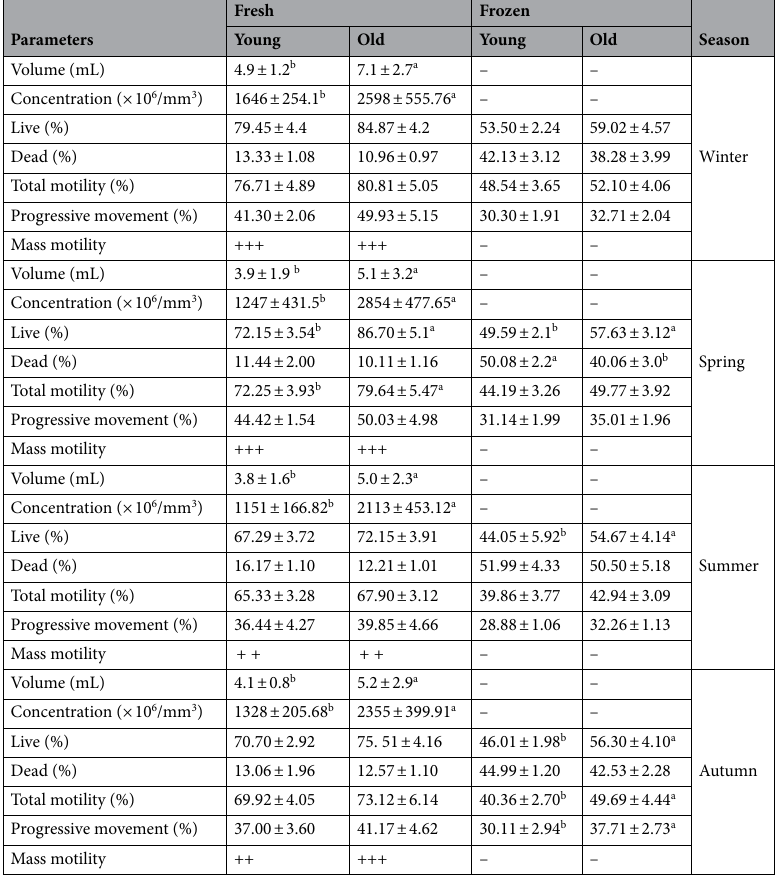
Table 9. Quality parameters of fresh and frozen semen of young and old bulls depending on the season (mean ± SD). Description: Values with different letters (a, b) differ significantly between columns at P <